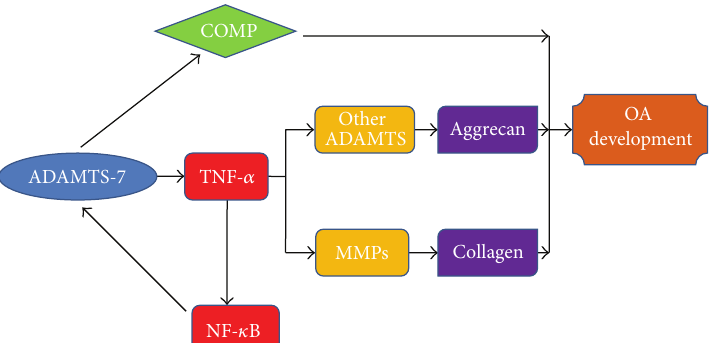
Figure 2: A proposed model for the potential role and mechanism of ADAMTS-7 in the regulation of OA development (edited according to [25]).